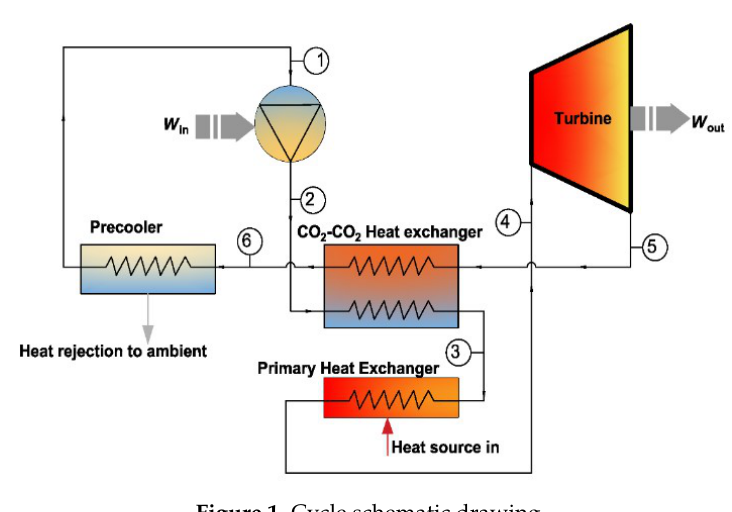
Figure 1. Cycle schematic drawing.